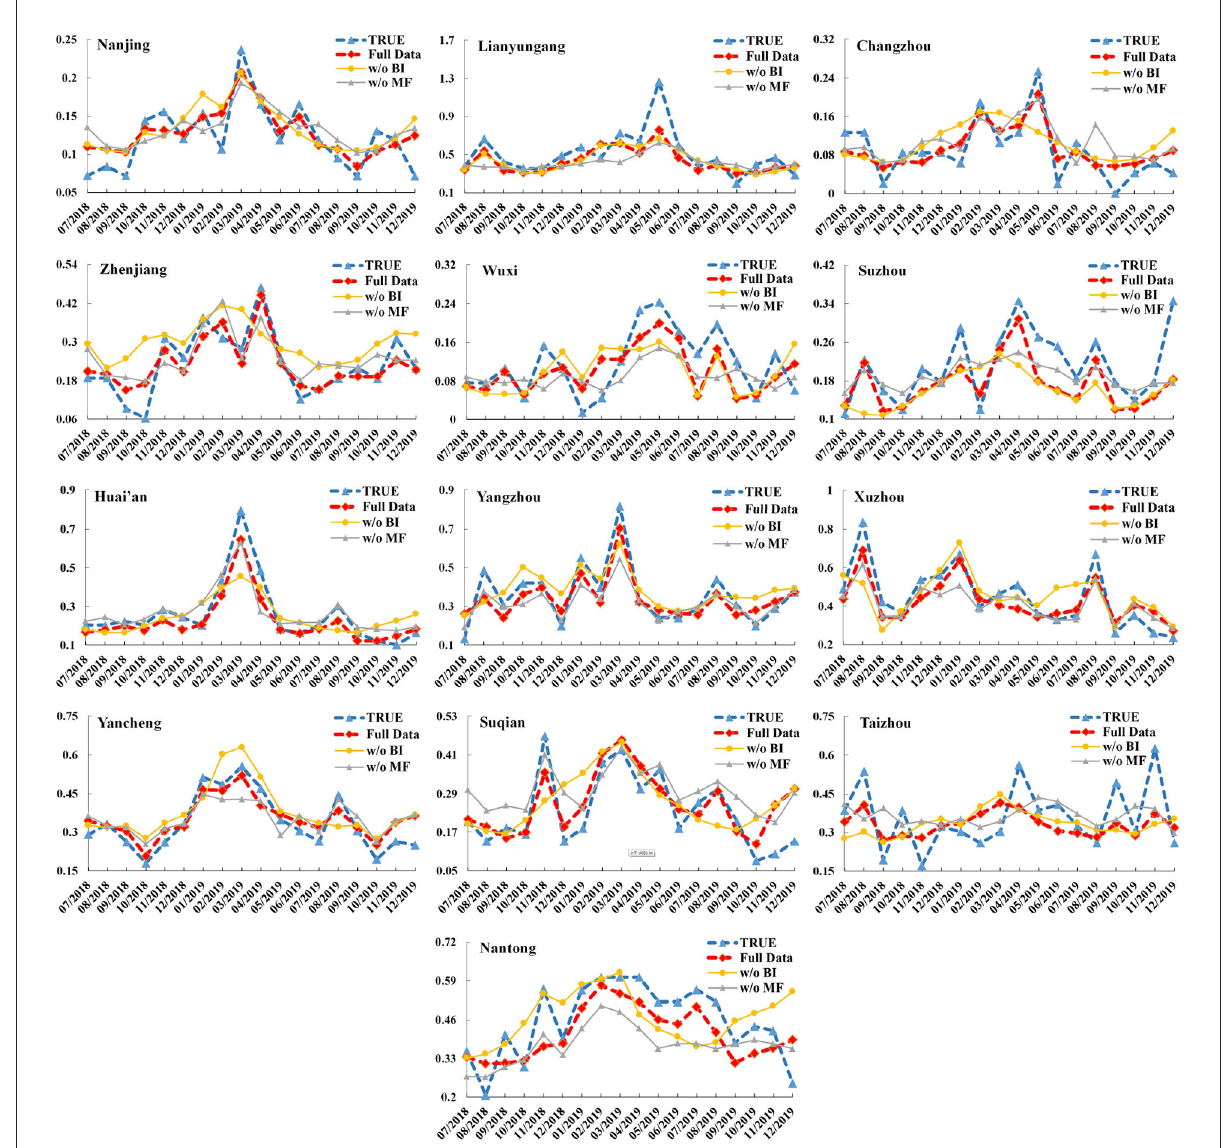
FIGURE5 The monthly incidence rates (including the true results and predicted ones of the BiLSTM–Attention model with full training data, w/o BI, and w/o MF) of hepatitis E for the 13 cities in Jiangsu Province (x-axis: month, y-axis: incidence